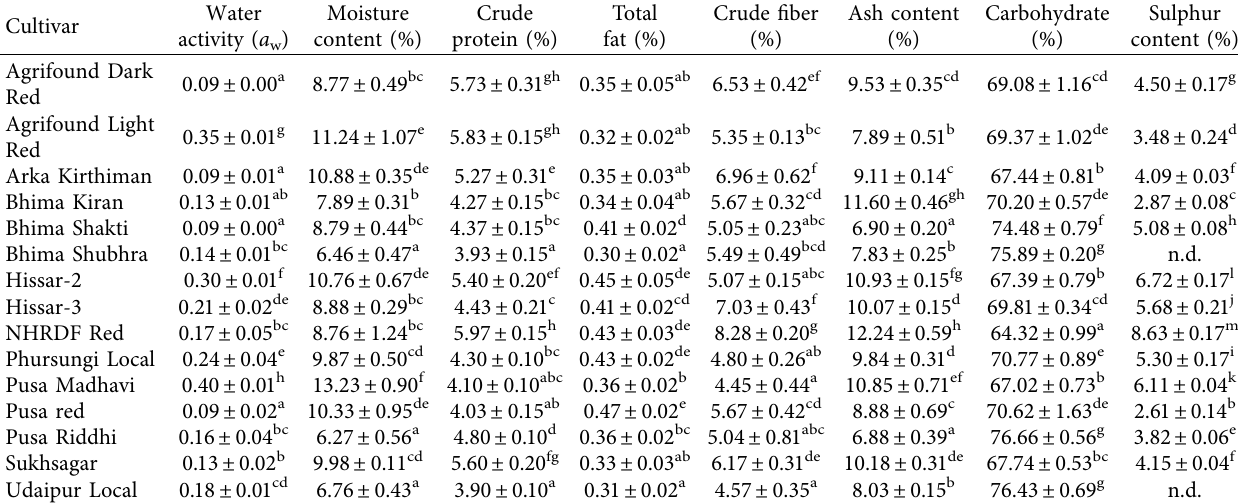
Table 1: Physicochemical composition of onion skin powder of fifteen